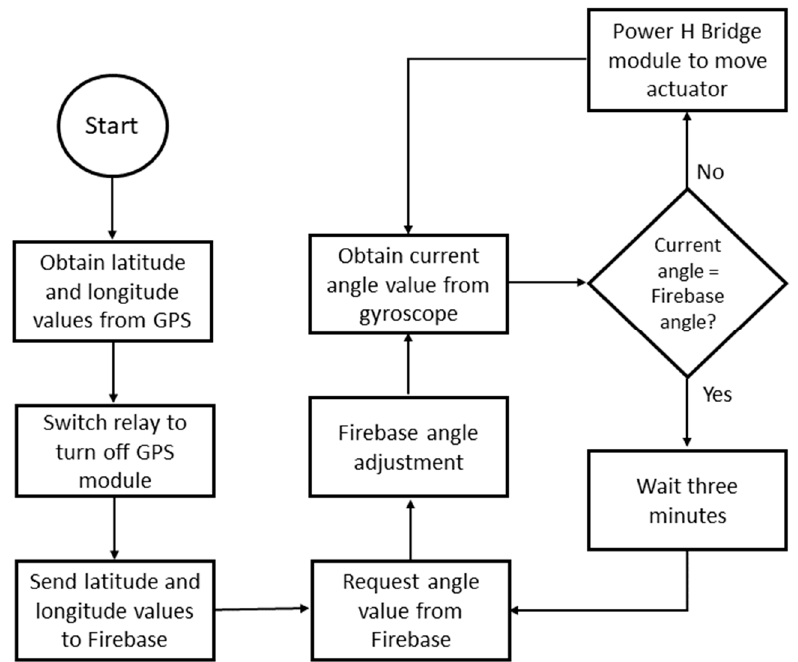
Figure 6. Flow diagram representing the algorithm used by the control circuit.